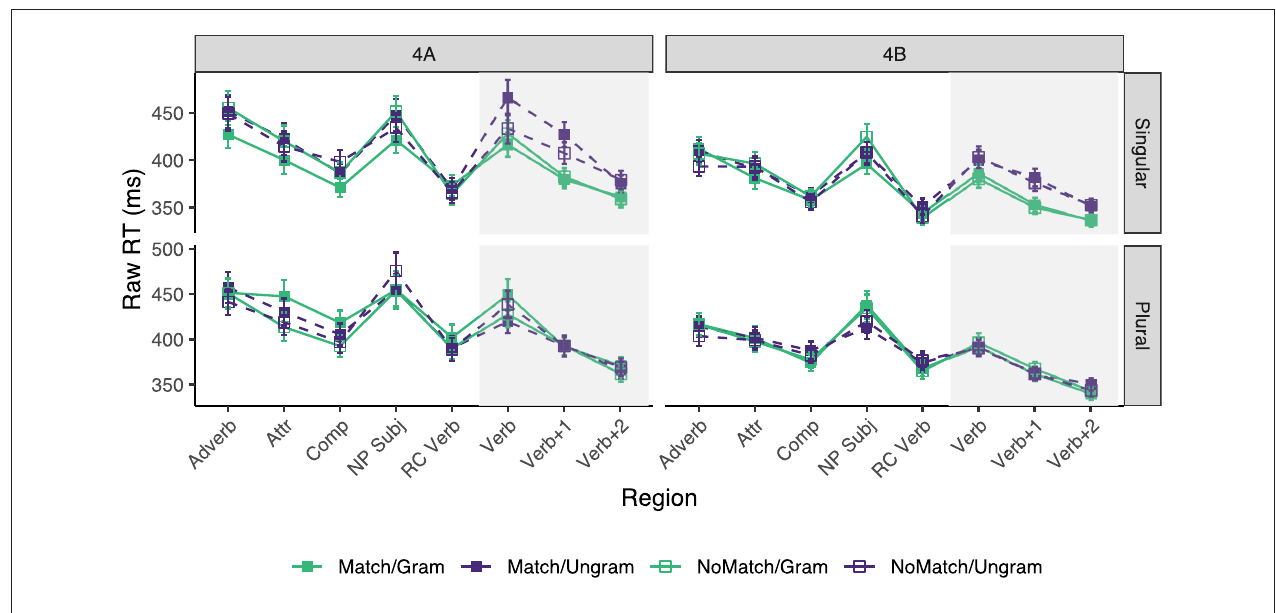
Figure 4 | Mean raw reading times from Experiment 4 for all conditions and regions by subject number. Error bars represent the standard error of the condition mean across participant averages.